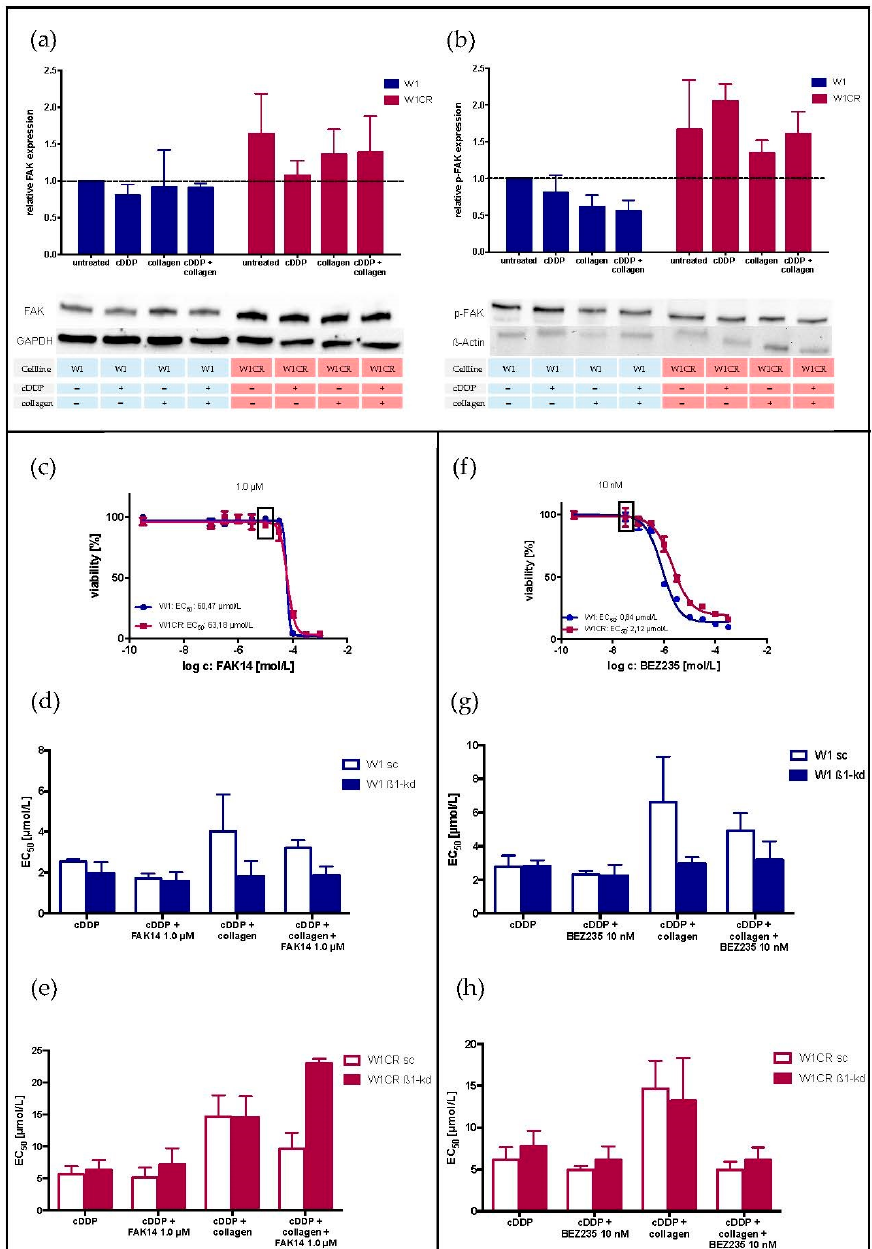
Figure 2. The impact of FAK and PI3K on resistance formation in W1 and W1CR cells as a potential target for sensitization: the expression of FAK ( a ) and p-FAK ( b ) in W1 and W1CR cells upon the indicated treatment regime was detected by Western blot. ( c ) Cytotoxicity of FAK14 in W1 and W1CR cells to select a non-toxic concentration of 1 µ M to be used for a co-treatment with cisplatin. ( d,e ) Blocking FAK (1.0 µ M FAK14) and the impact on cisplatin toxicity in W1 scramble or W1 ITGB1 knockdown cells ( d ) and W1CR scramble and W1CR ITGB1 knockdown cells ( e ). ( f ) Cytotoxicity of the PI3K inhibitor BEZ235 in W1 and W1CR cells to determine a non-toxic concentration of 10 nM for combination with cisplatin treatment in these cells. ( g,h ) Cisplatin cytotoxicity upon PI3K inhibition (10 nM BEZ235) in W1 scramble and W1 ITGB1 knockdown cells ( g ) and W1CR scramble and W1CR ITGB1 knockdown cells ( h ). Data are means of at least n = 3 ( ± SEM). Concerning PI3K, both cell lines express comparable levels of PI3K and pPI3K, which were not upregulated by cell treatment with cisplatin or even COL1 binding (Figure S2a,b).